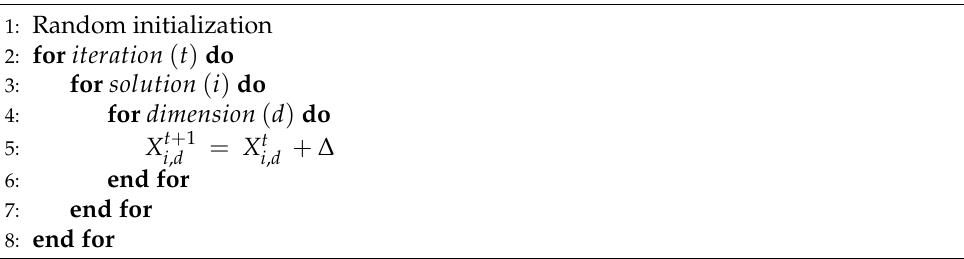
Algorithm 4 Discrete general scheme of